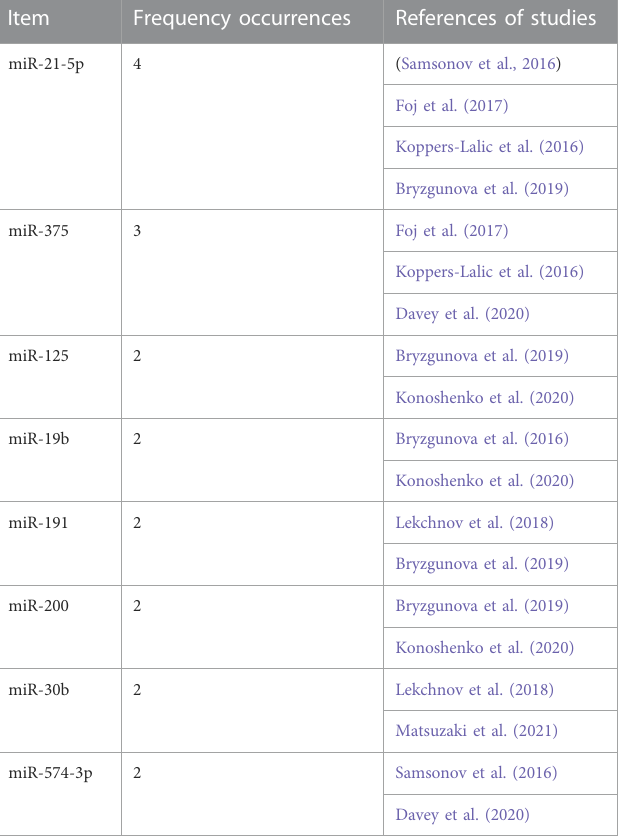
TABLE 5 Proposed miRNAs panel with potential use for the discrimination between control or bening prostatic hyperplasia populations and prostate cancer patients. Using each miRNA as an array element, the table shows the reporting frequency for each miRNA and the studies where they were